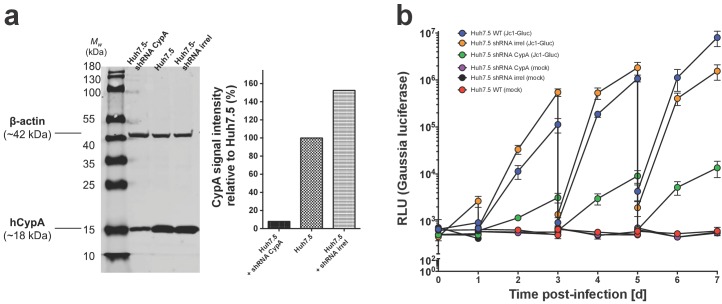
Assessment of Huh7.5-shRNA CypA cells.(A) Western blot demonstrating knockdown of human CypA in Huh7.5-shRNA CypA cells relative to the parental Huh7.5 cells and those expressing an shRNA against an irrelevant target (Huh7.5-shRNA irrel). Quantification of signal intensity was done using LI-COR Image Studio Software (version 4.0) with background detection set to ‘Median.’ CypA signal intensity was normalized based off that of β-actin and is expressed here relative to Huh7.5 cells (set at 100%). (B) HCV replication is specifically diminished in Huh7.5-shRNA CypA cells and not Huh7.5-shRNA irrel cells. Infection performed with Jc1-Gluc (MOI = 0.1). On even-numbered days, cells were washed with PBS and the media changed to assess de novo replication. Lines and error bars represent the mean ± SD.